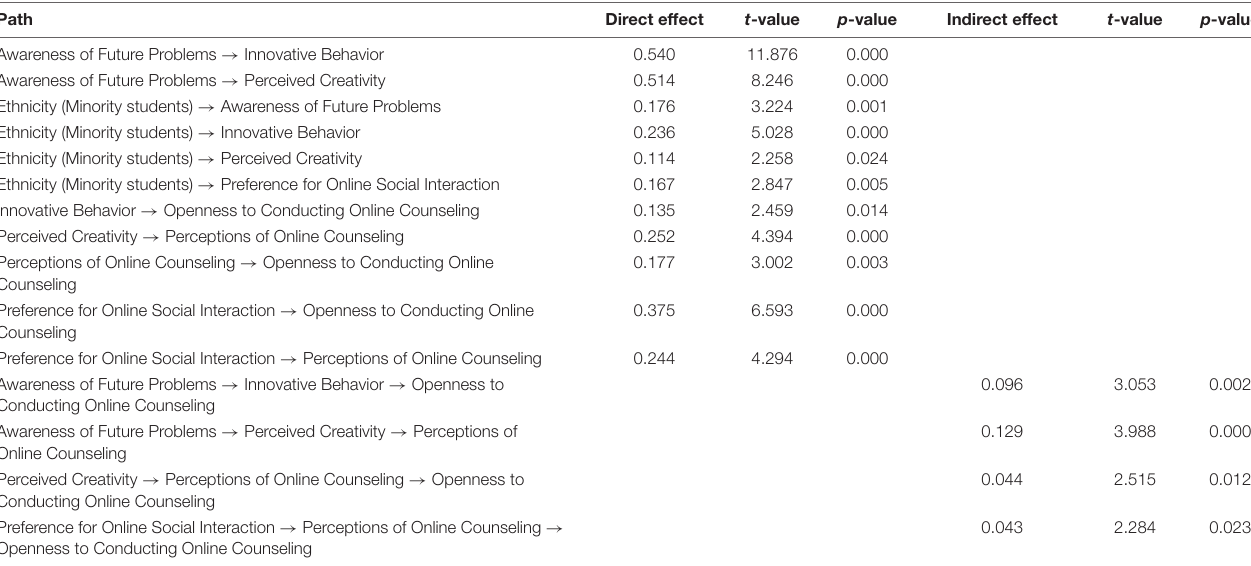
TABLE 2 | Significance analysis of the direct and indirect